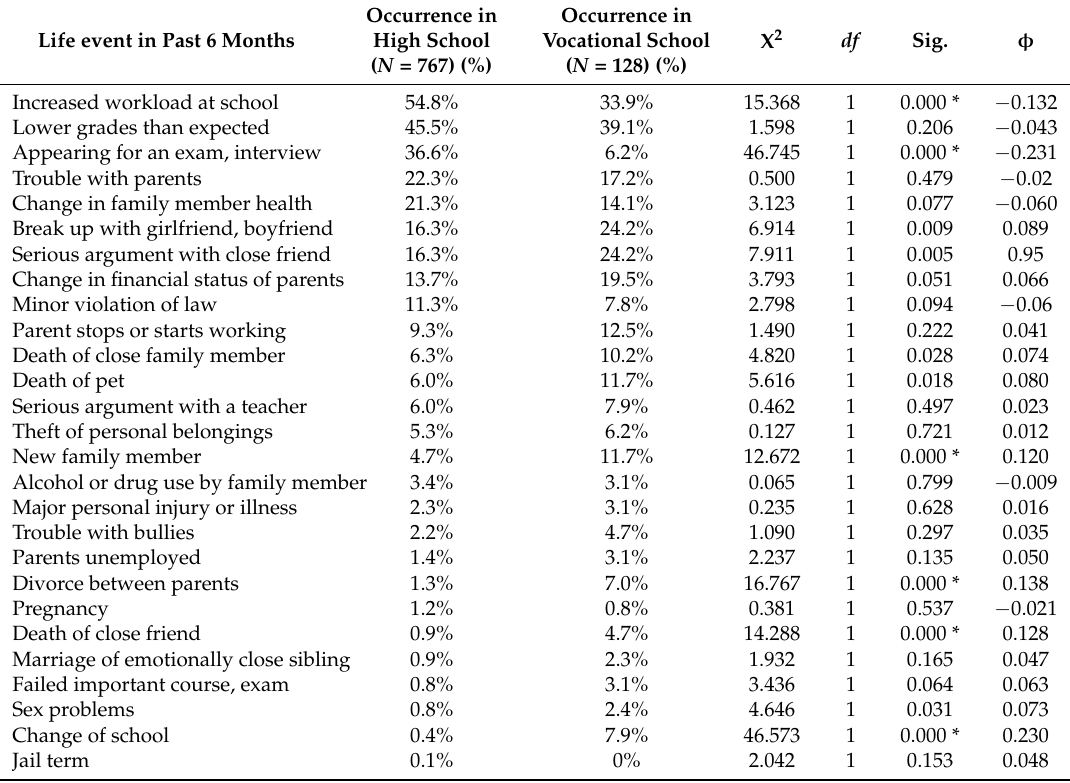
Table 2. Life events among high school and vocational school